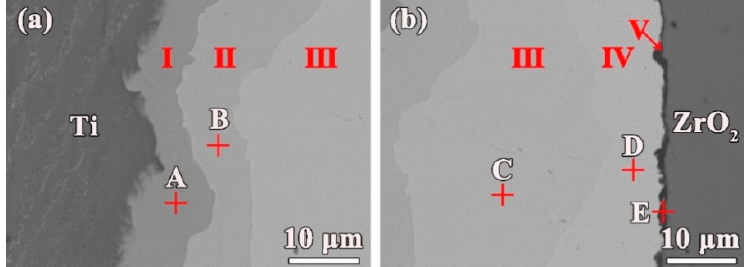
Figure 3. Magnification microstructure of the titanium/Au/ZrO 2 joint: ( a ) the titanium/brazing seam interface; ( b ) the brazing seam/ZrO 2 interface. Table 1. Energy dispersive spectroscopy (EDS) results of the spots marked in Figure 3 (at. %). Spot Ti